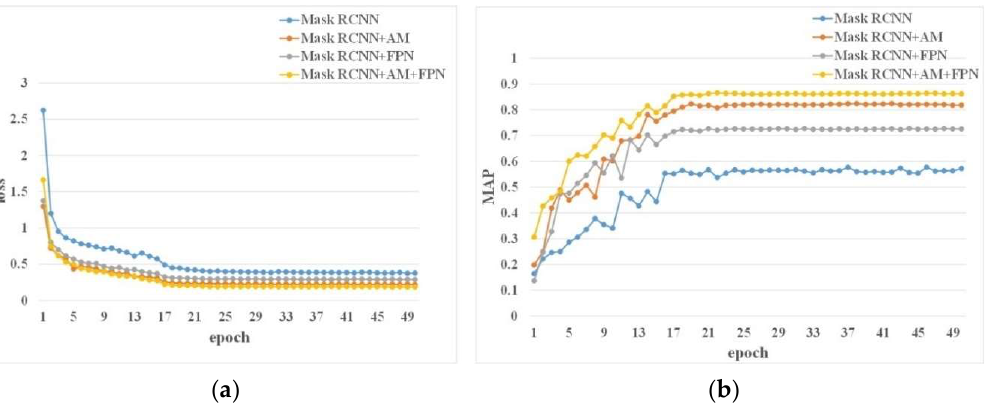
Figure 8. Loss and mAP of the models. ( a ) Loss curves of the models. ( b ) mAP curves of the models. Table 2. Validation metrics of different